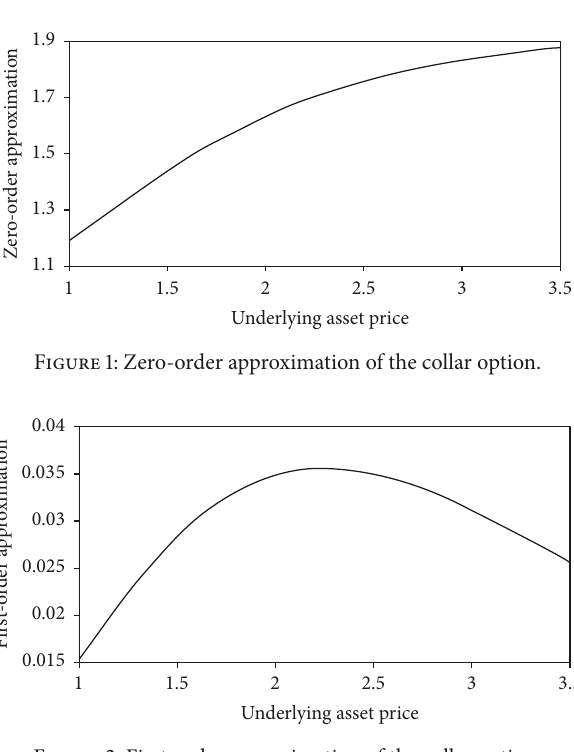
Figure 2: First-order approximation of the collar